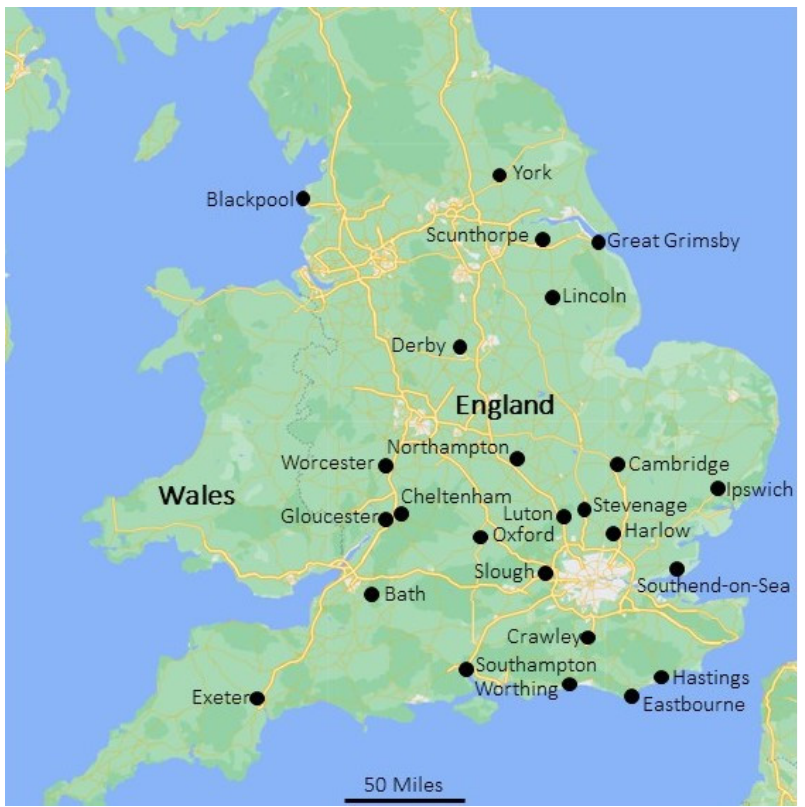
Figure 1. The locations of the 25 cities used in Burton’s studies on a partial map of the UK. Based on her statistical analysis of the urban compactness and social equity measures Burton [4] ranked her 25 cities from high to low based on the density, mix-of-use, of the 25 cities, collected from a variety of sources, Burton [2] reported the following find- ings: and intensification indicators, as well as based on the composite indicators of these three dimensions of urban compactness. She found that there are differences between the three categories of indicators for the towns scoring high and low. In other words, a compact